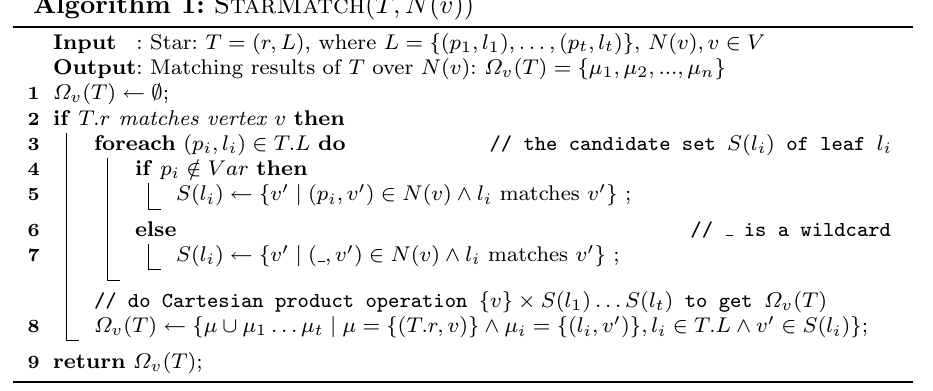
Algorithm 1: StarMatch ( T, N ( v